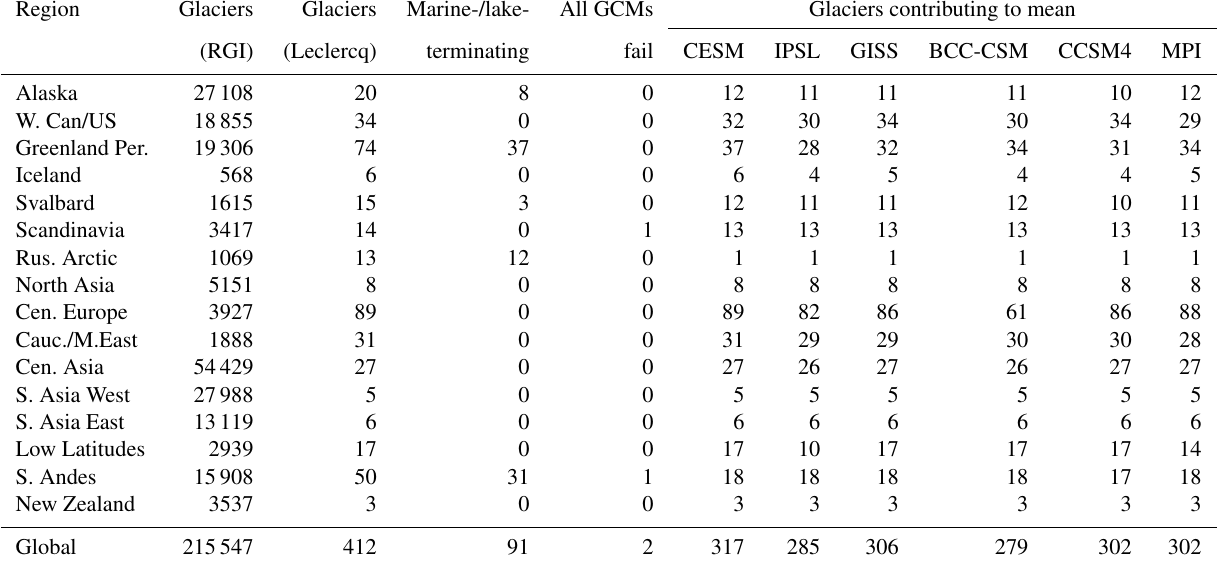
Table 1. Breakdown of the glaciers modelled by region, showing the two reasons glaciers may be removed from contributing to regional means: the glaciers being flagged in the RGI as marine- or lake-terminating and a failure in the modelling process for all six general circulation models (GCMs). For each GCM, the set of glaciers that contribute to the regional mean length changes (any failures for that specific GCM also removed) is shown. Total glaciers in the RGI are shown for comparison, to provide an idea of how well-represented each region is in the Leclercq dataset.